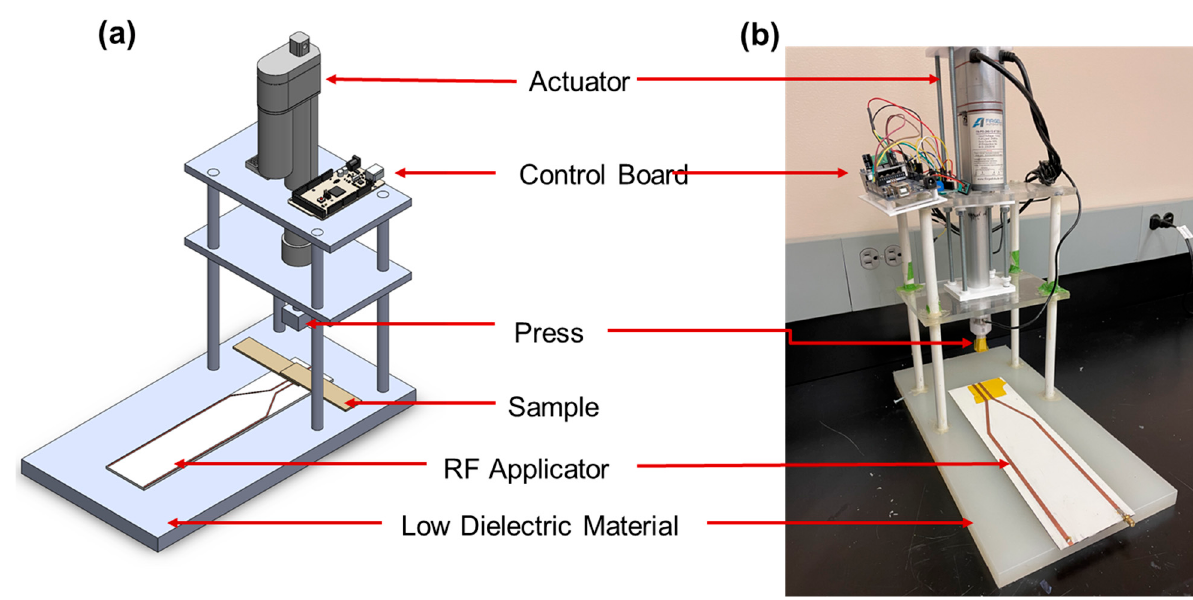
Figure 4. ( a ) CAD model of the design and ( b ) fabricated RF welding